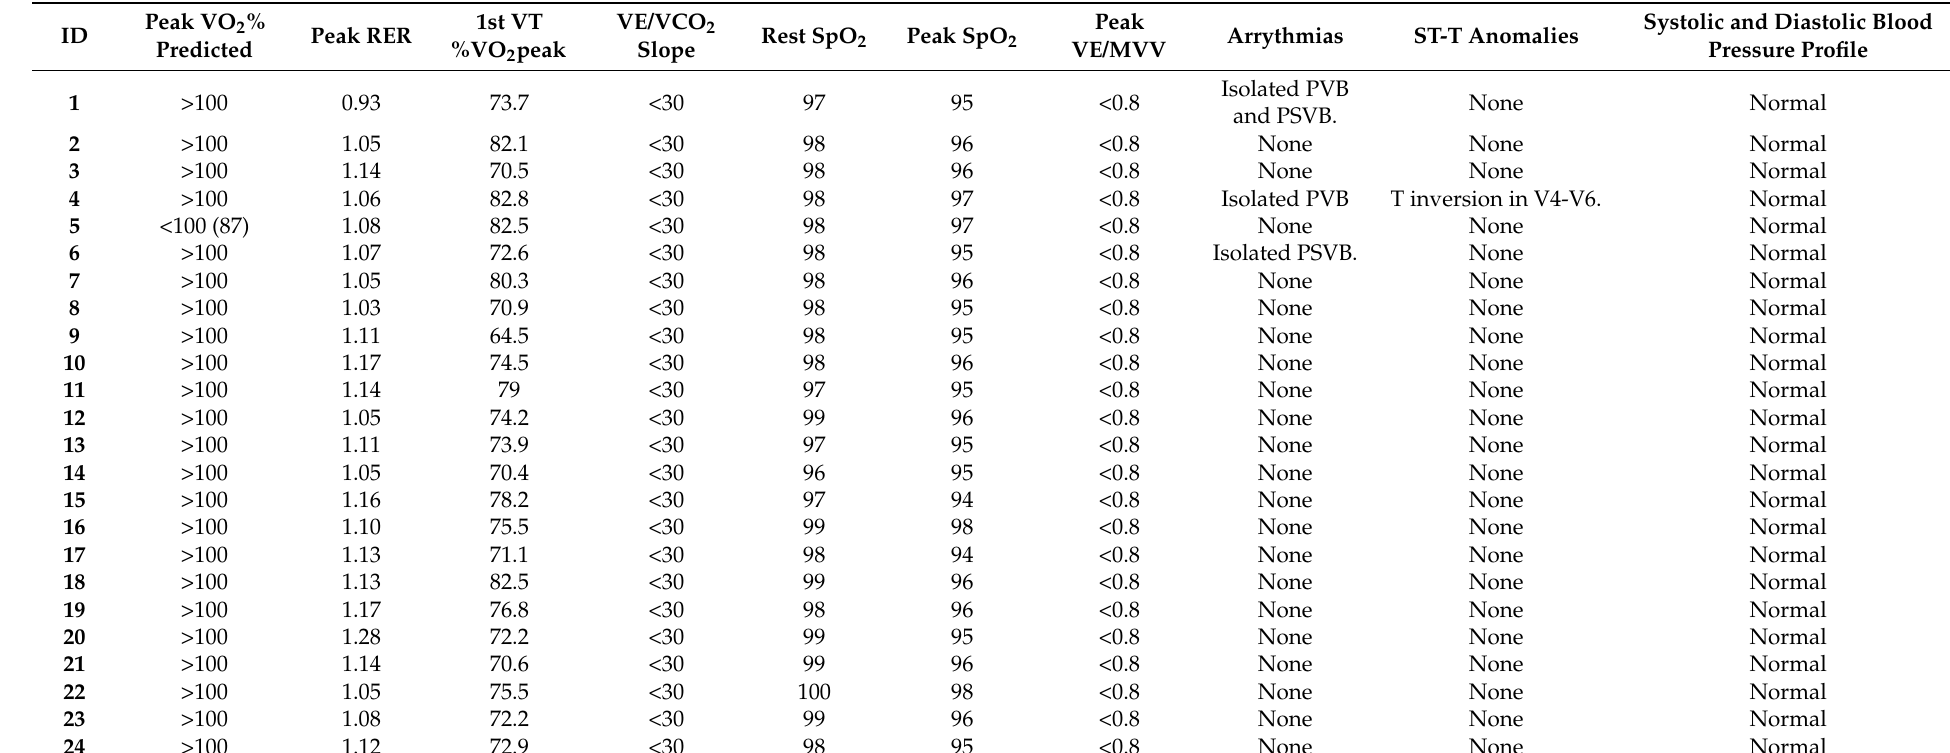
Table 2. Description of CPET in COVID-19